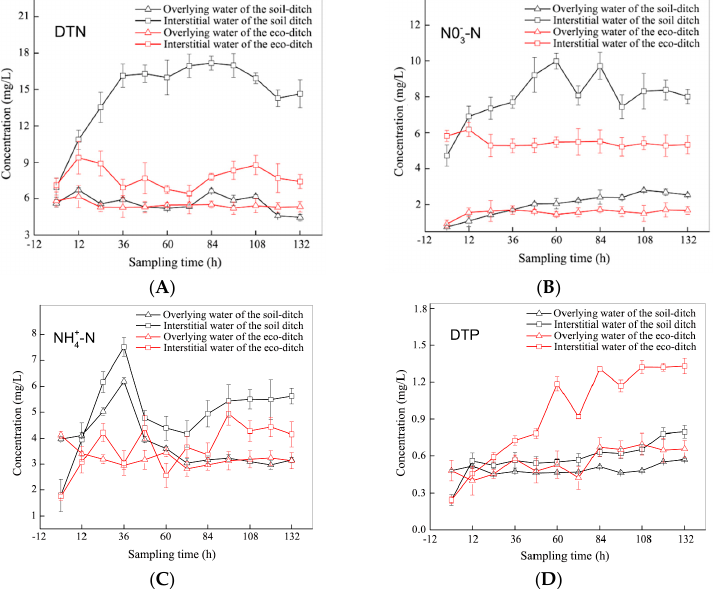
Figure 5. Changes of NH 4 + -N ( A ), NO 3 − -N ( B ), DTN ( C ), and DTP ( D ) in sediments and overlying water of the eco-ditch and the soil ditch over time.